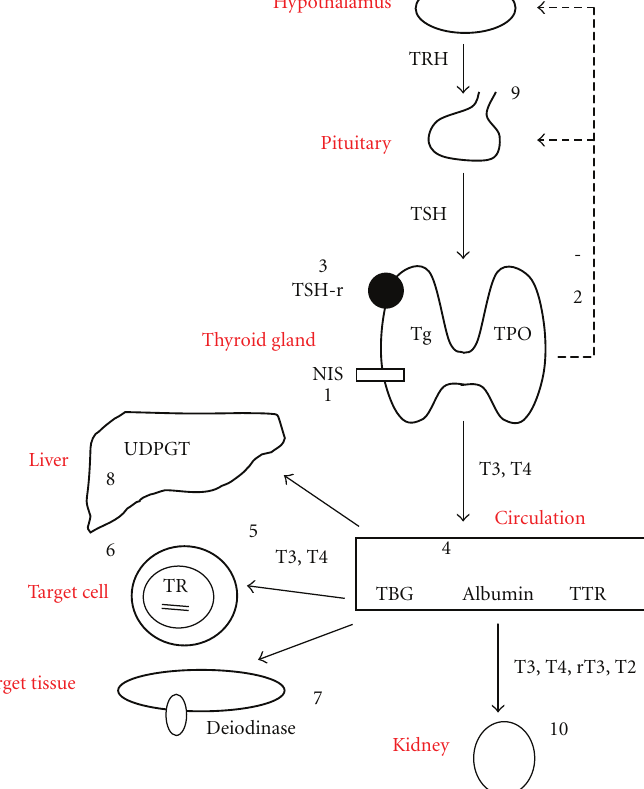
Figure 1: The complex mechanisms of regulation of thyroid hormone homeostasis and the possible mechanism of action of the thyroid disrupting chemicals. The thyroid and the thyroid hormones, tri-iodothyronine (T3) and thyroxine (T4), participate with the hypothalamus, secreting thyrotropin releasing hormone (TRH), and pituitary, secreting thyrotropin (TSH) in a classical feedback controlled loop. Iodide is transported into the cell by the sodium-iodine symporter (NIS) and oxidized by thyroid peroxidase (TPO). TPO also catalyzes the iodination of thyrosine residues on thyroglobulin (Tg). All processes in the cell are stimulated by binding of TSH to the TSH receptor (TSH-R). In the circulation, thyroid hormones are bound to thyroxine-binding globulin (TBG), albumin and prealbumin, and in some cases transthyretin (TTR). T4 is deiodinated by deiodinases in the liver and target tissues. In the target cells, T3 binds to nuclear thyroid hormone receptor (TR), and with the retinoid X receptor, it binds at specific sequences at the DNA string, forming the thyroid hormone response elements (TRE). In the liver, thyroid hormones are metabolized by UDP-glucuronyl transferase (UDPGT), and finally, the metabolites are excreted in the urine. (1) Inhibition of iodine uptake in the cells by inhibition of NIS: perchlorate, thiocyanate, nitrate, and phthalates. (2) TPO inhibition: NP and isoflavones. (3) Inhibition of TSH-R: DDT and PCB. (4) Binding to transport proteins: PCB, phthalates, phenol, flame retardants, and HCB. (5) Cellular uptake of thyroid hormones: phthalates and chlordanes. (6) Binding to thyroid hormone receptor and a ff ecting gene expression: PCB, phenols, flame retardants, BPA and HCB. (7) Inhibition of deiodinases: Styrenes and UV-filters, (8) Activation of hepatic UDPGT: dioxins and pesticides, (9) Inhibition of the hypothalamo-pituitary-thyroid axis: lead. (10) Excretion/clearance of thyroid hormones: PCB, dioxin, phenols, flame retardants, HCB, and